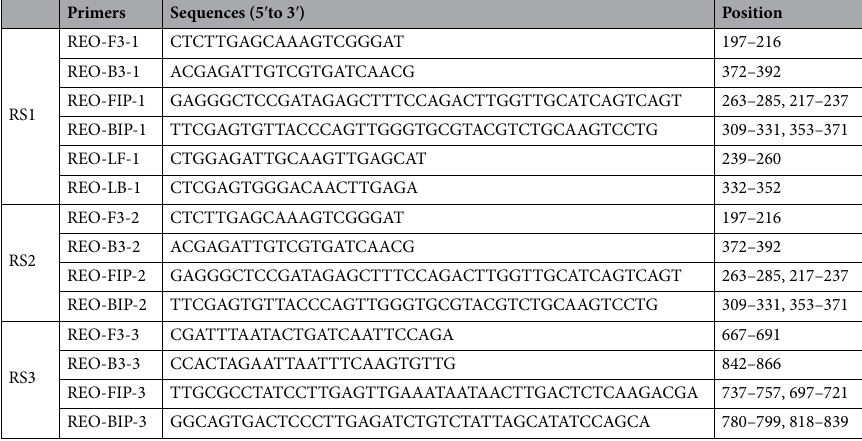
Table 1. Primer sets for loop-mediated isothermal